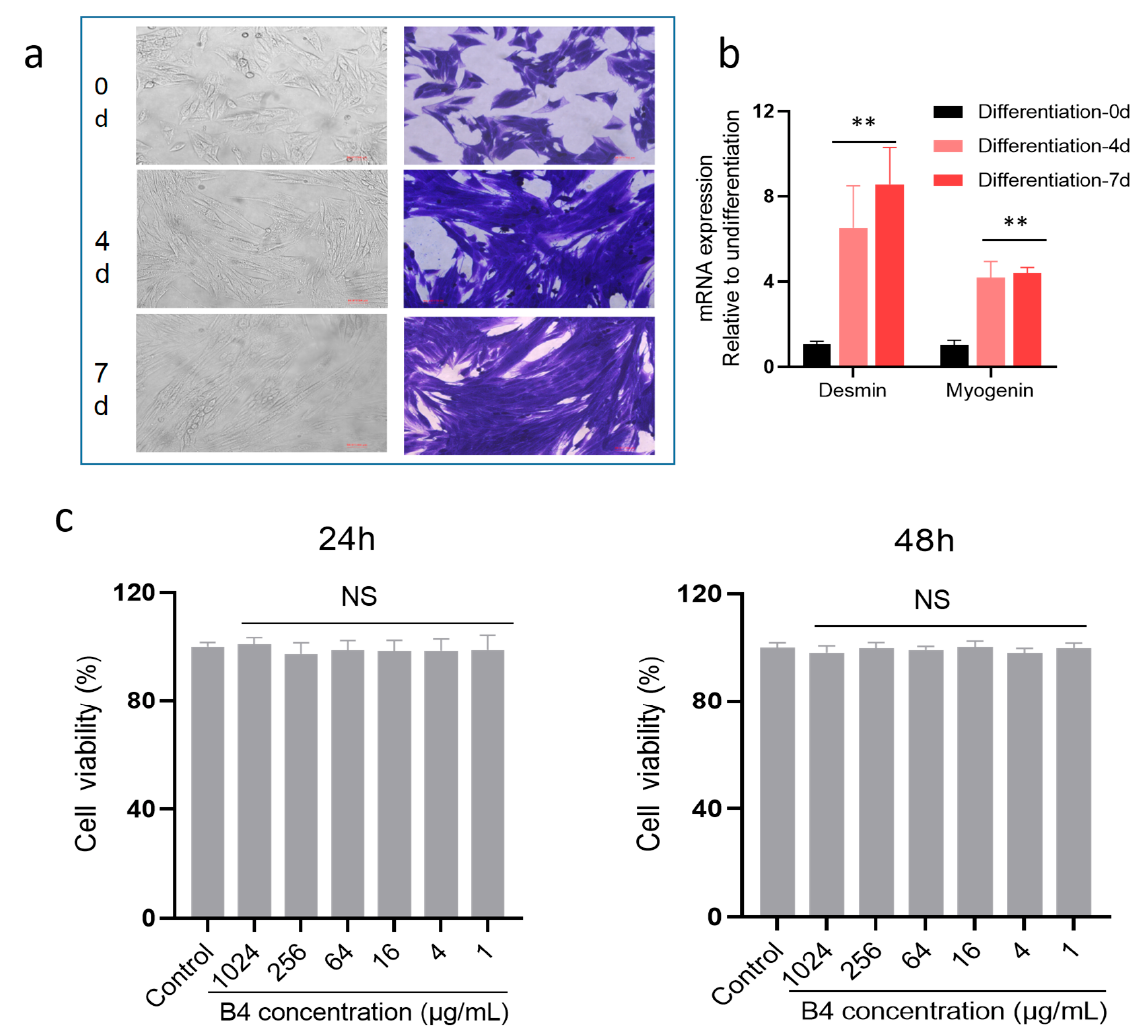
Figure 4. Differentiation of L6 myoblasts and cell viability. ( a ) Days 0, 4, and 7 of L6 differentiation and cells were stained by coomassie brilliant blue; ( b ) mRNA expression of desmin and myogenin was detected by PCR assay; ( c ) Cell viability of L6 cells was examined after 24 and 48 h of B4 treatment. ** p < 0.01 vs. Differentiation 0d group. NS (no significance) vs. control group. Data represent the mean ± standard error of three separate